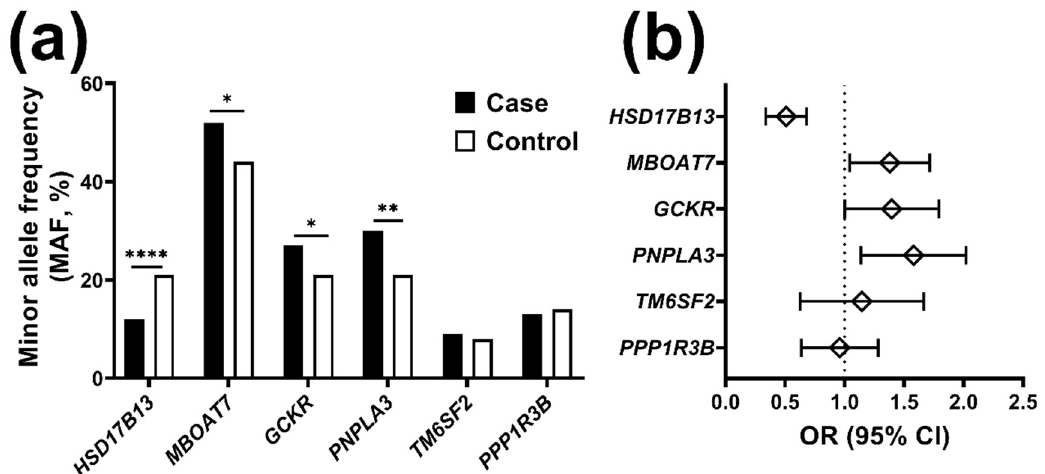
Figure 1. Minor allele frequency of main genetic determinants of liver disease and the corresponding risk for chronic liver disease in Pakistani individuals. ( a ) Minor allele frequency of main genetic determinants of liver disease stratified by case and control group. Data are shown as percentage. P-values calculated by chi-square. ( b ) The risk for chronic liver disease conferred by the minor allele of the main genetic determinants of chronic liver disease expressed as Odds ratio (OR) and its 95% confidence interval (CI). The risk was estimated by binary logistic regression under an additive genetic model with the exception of TM6SF2 where a dominant genetic model has been assumed, considering the relative lower MAF. Case group: n = 587 individuals with chronic liver disease ( n = 522 viral and 62 non-viral). Control group: n = 164 individuals without liver disease ( n = 68 recruited in the present study plus 96 Punjabi individuals reported on 1000 Genomes Project ((Ensembl release